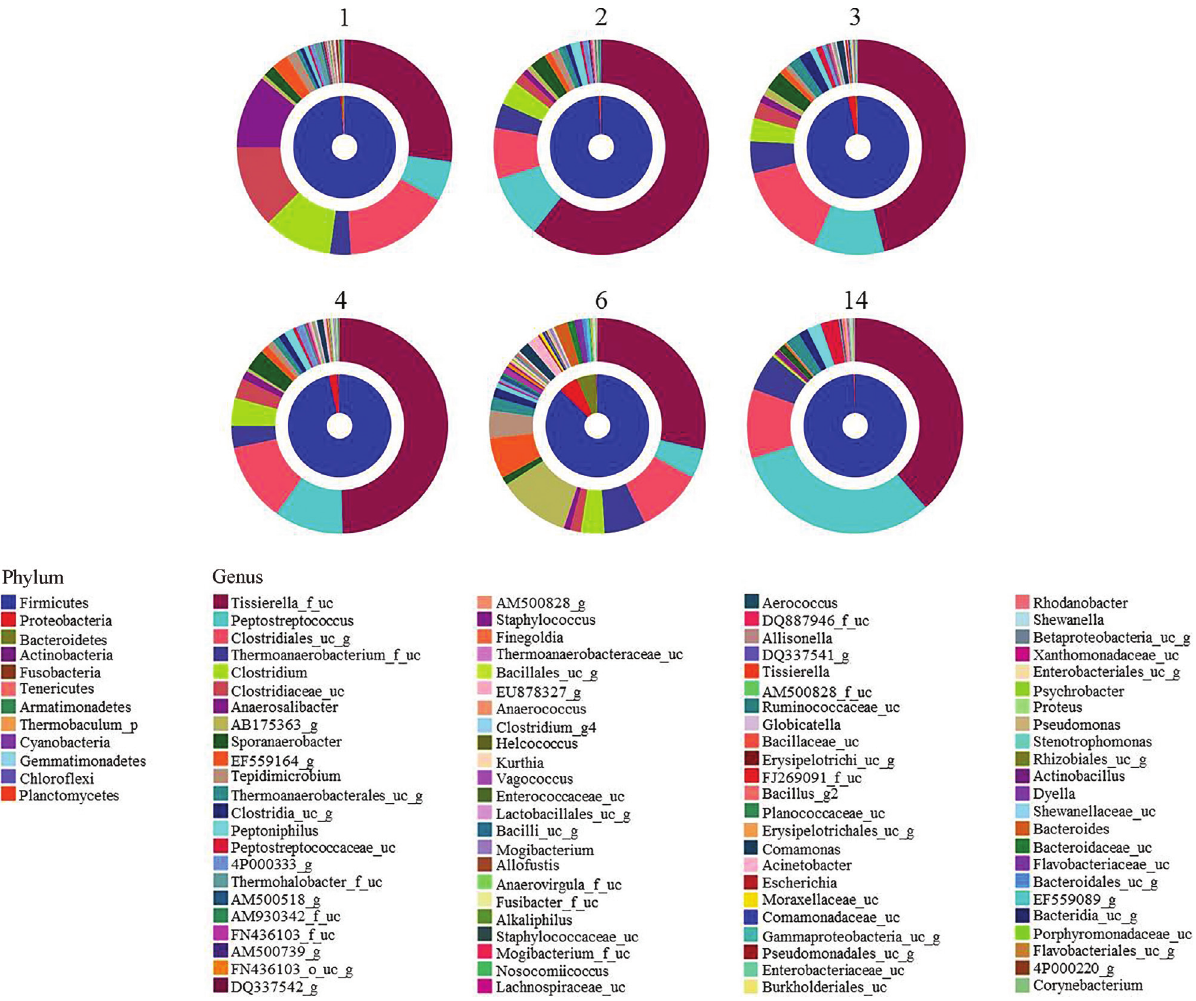
Figure2 -Doublepiechartsofbacterialcommunities.Theinnerandouterpiesrepresentthecompositionofphylaandgenera,respectively.Thenumbers above each pie indicates the sampling time. The nomenclature of phylotypes is based on the EzTaxon-e database (Kim et al. , 2012b;